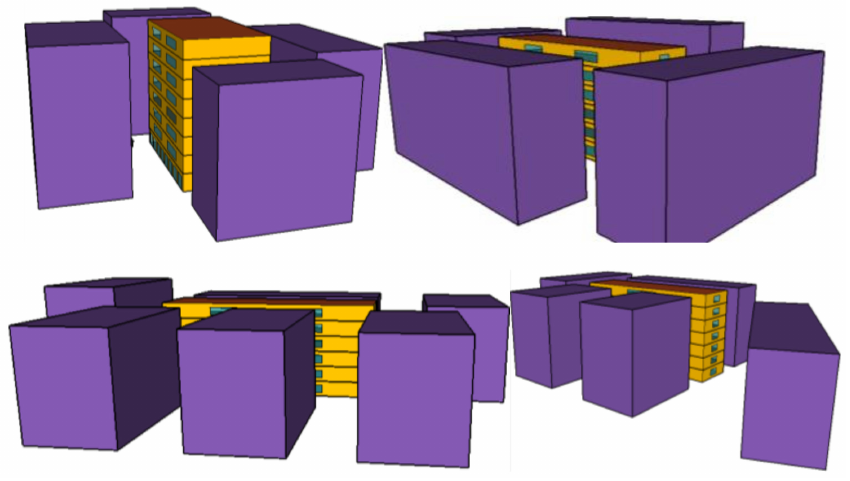
Figure 4. Building shading.